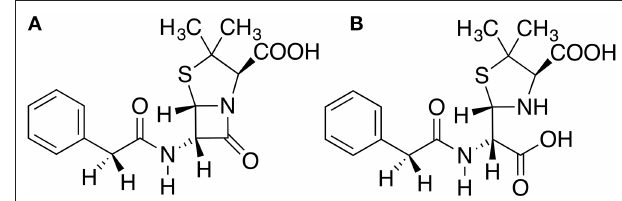
FIGURE 1 | Chemical structures of (A) Benzyl penicillin, (B) the hydrolysis product of benzyl